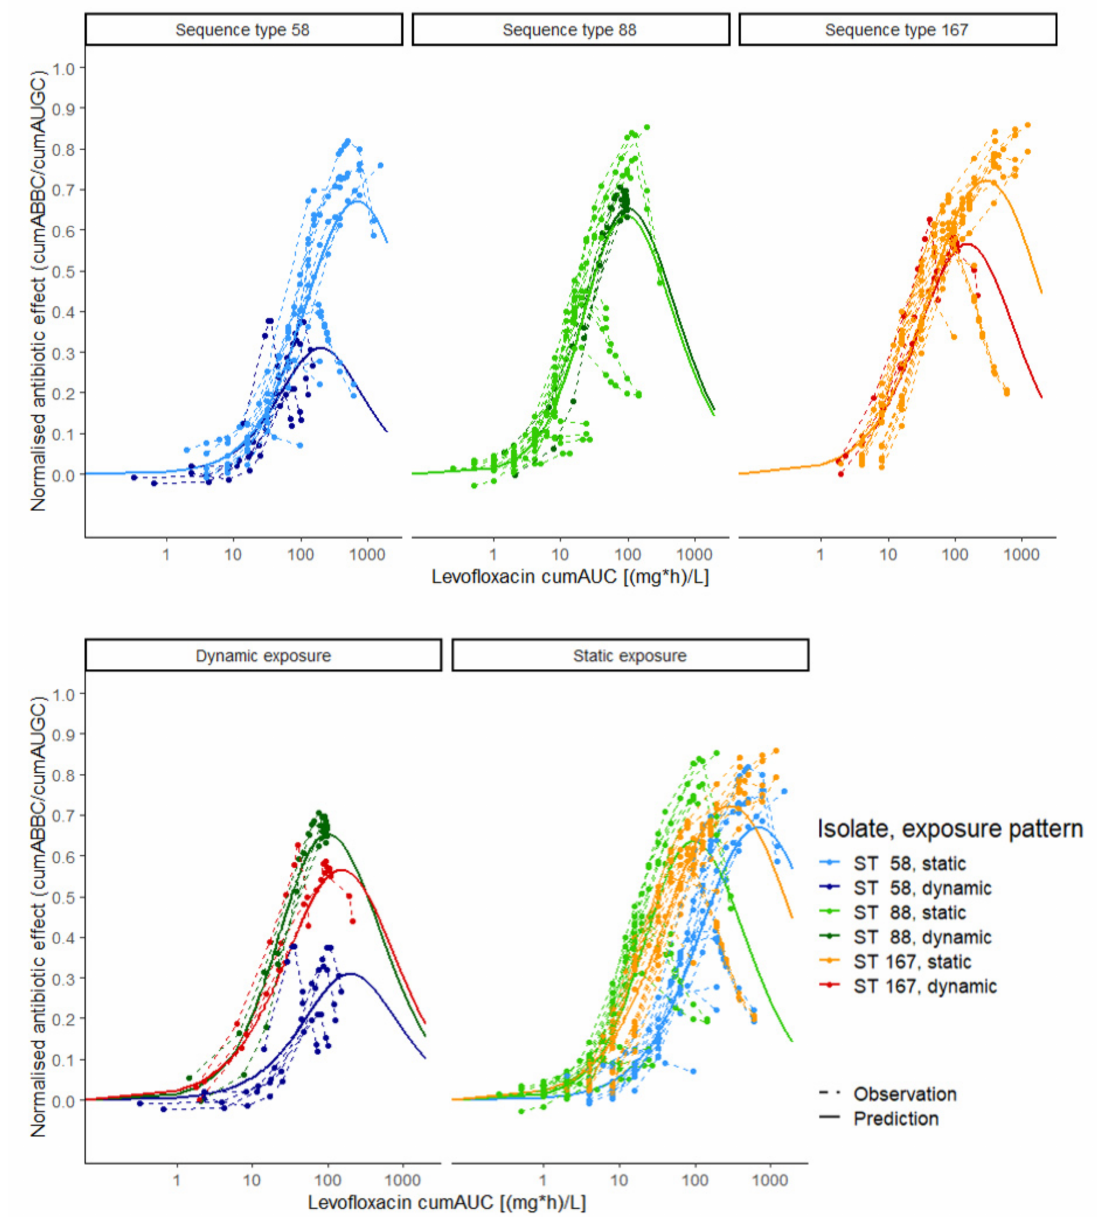
Figure 1. Exposure–effect relationship of levofloxacin against Escherichia coli in static and dynamic in vitro infection model experiments. Exposure was determined as the cumulative area under the levofloxacin concentration–time curve (cumAUC(t)); effect was determined as the cumulative area between the growth control and the bacterial killing and regrowth curve (cumABBC(t)), normalised to the area under the growth control curve (cumAUGC(t)); observations (points and dashed lines) and predictions (solid lines) were based on the E max model with inhibition term. Colours: three Escherichia coli isolates under dynamic (dark green, red and blue) and static (light green, orange and light blue) exposure; upper panel: exposure–effect relationship per isolate; lower panel: exposure–effect relationship per exposure pattern; ST: sequence